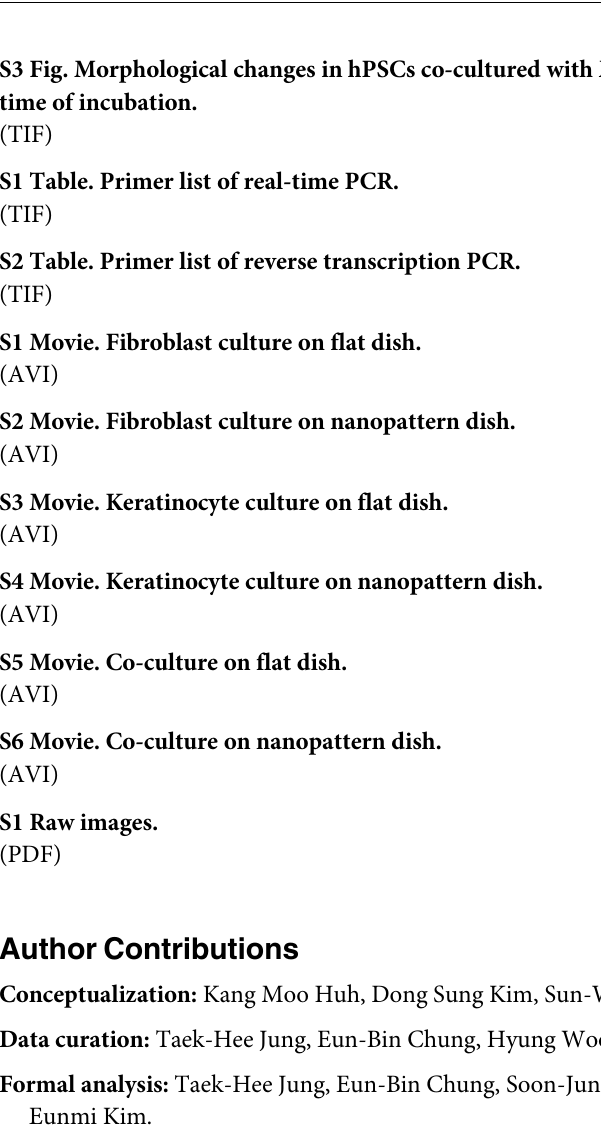
S3 Fig. Morphological changes in hPSCs co-cultured with MMC-treated fibroblasts over time of incubation. S1 Table. Primer list of real-time PCR. S2 Table. Primer list of reverse transcription